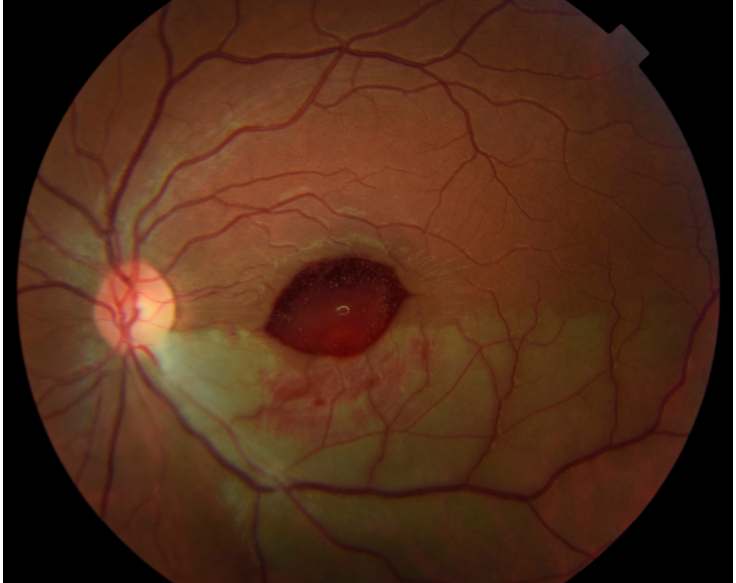
Figure 3. Color fundus photograph of the left eye at follow-up 2 weeks after administration of tissue plasminogen activator (tPA) shows new ellipsoid-shaped hemorrhage blocking the central macula and slightly improved inferior retinal whitening.